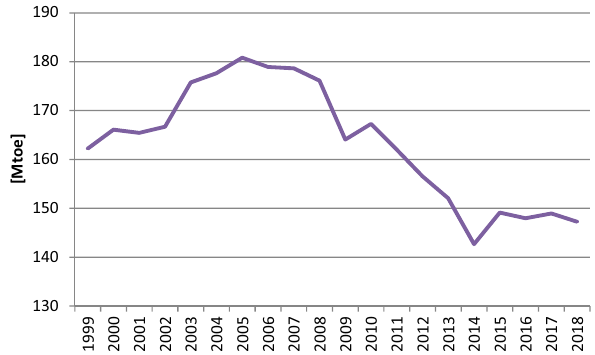
Figure 7: Primary energy consumption in Italy in the years 1999 – 2018. Source: own work based on ref. [ 5 ]